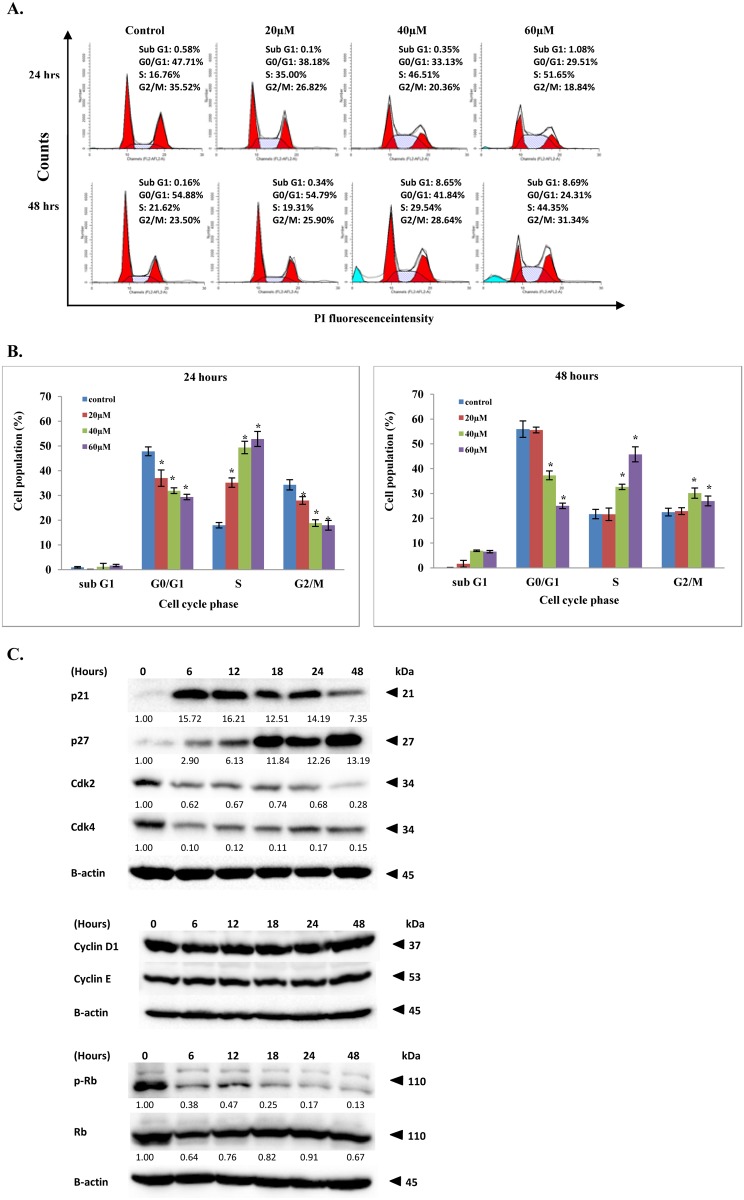
Effect of FKC on the cell cycle and the cell cycle regulatory proteins in HCT 116 cells.(A) Cells were treated with the indicated concentrations of FKC for 24 and 48 hours, and stained with PI. DNA content of HCT 116 was analyzed using flow cytometry and quantification of cell cycle distribution(sub-G1, G0/G1, S and G2/M phases)was performed using ModFit software. Untreated cells in 0.5% DMSO served as the control. Each histogram is the representative cell cycle profile of three independent experiments. (B) The quantitative data of mean of percentages of cells in each phase for HCT 116 cells for 24 and 48 hours are presented in bar chart. Values given are expressed as mean ± SD of triplicates obtained from three independent experiments. The asterisk (*) indicated p<0.05 when compared to the control. (C) Cells were incubated in the absence or presence of FKC (60μM) for the indicated times, and followed by protein extraction. Changes in levels of the cyclins (cyclin D1 and E), cyclin dependent kinase (Cdk2 and 4), Cdk inhibitors (p21Cip1 and p27Kip1), and RB phosphorylation were analyzed by Western blot. Untreated cells in 0.5% DMSO served as the control. β-actin was used as the loading control. The results from representative experiments were expressed relative to the proteins level at 0 hr after normalization to β-actin signals.